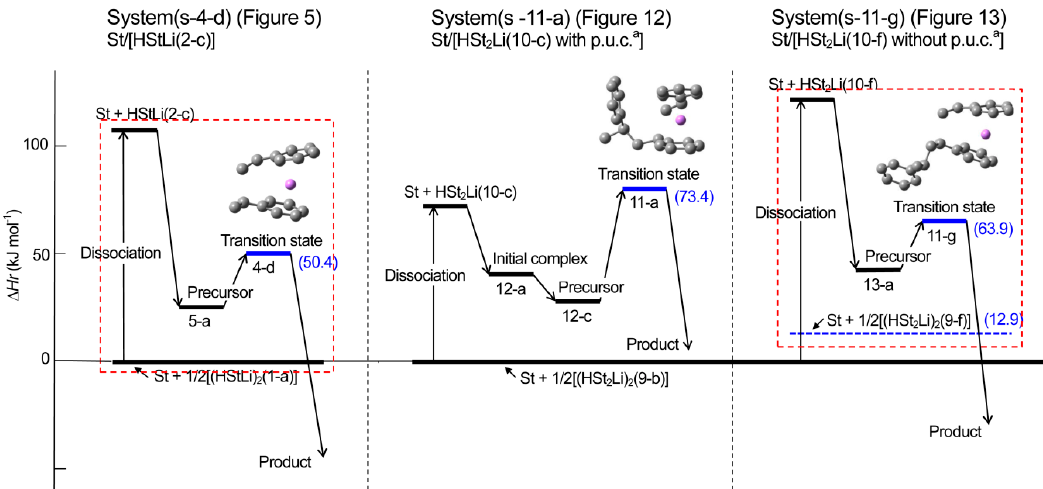
Figure 14. Enthalpy changes for the addition of styrene to HStLi and HSt 2 Li in the gas phase. The sub-transition state between the initial complex and the precursor for system(s-11-a) is not shown here. a p.u.c.: penultimate unit coordination.